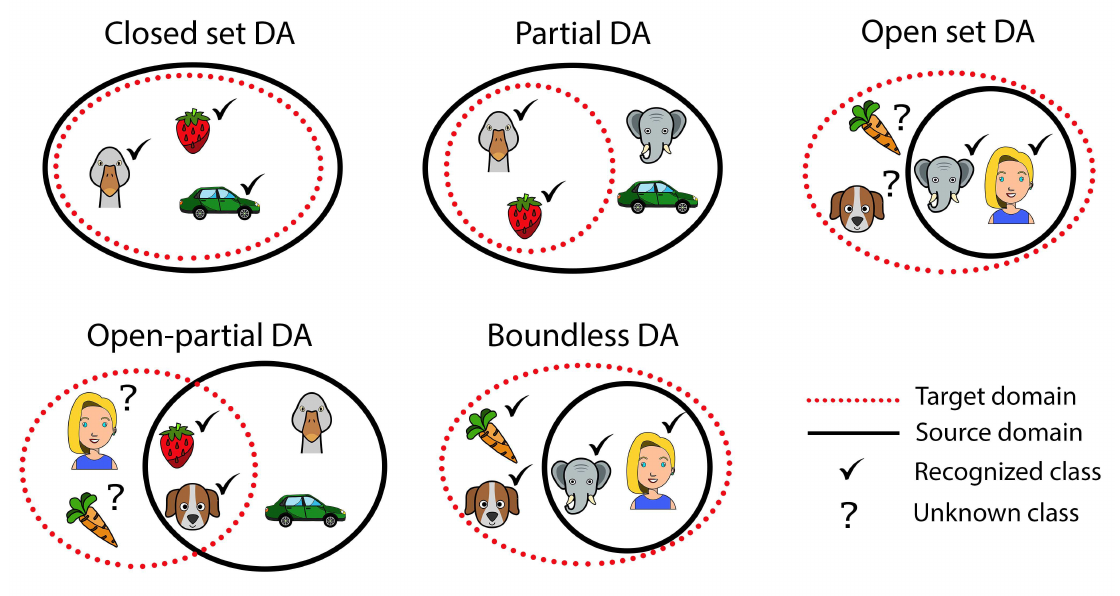
Figure 4. Possible intersections between source and target